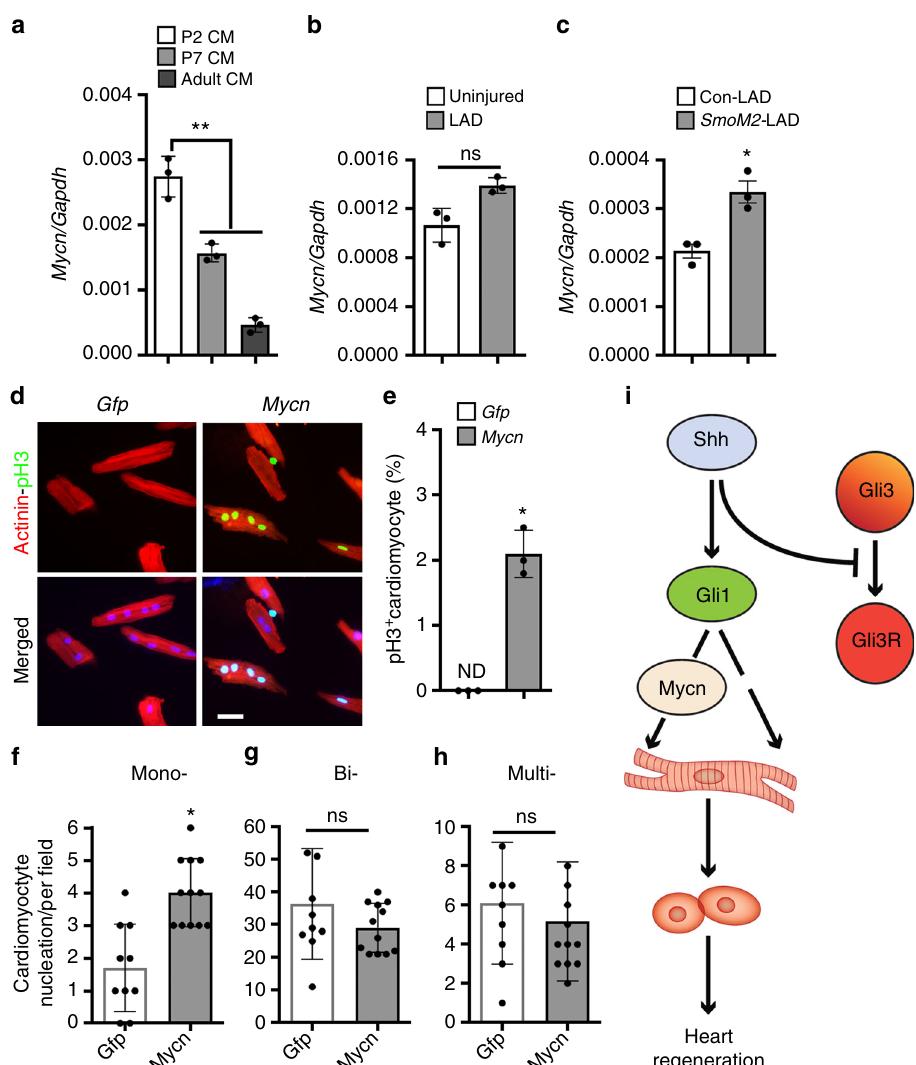
Fig. 9 Mycn recapitulates HH signaling-mediated adult cardiomyocyte proliferation. a qPCR analysis of Mycn transcripts using RNA obtained from isolated cardiomyocytes at P2, P7, and P60 mouse hearts ( n = 3). b qPCR analysis of Mycn transcripts using RNA obtained from adult uninjured and injured heart tissue at 7 days post-MI. c qPCR analysis of Mycn transcripts using RNA obtained from control and SmoM2 -expressing heart tissue following 7 days